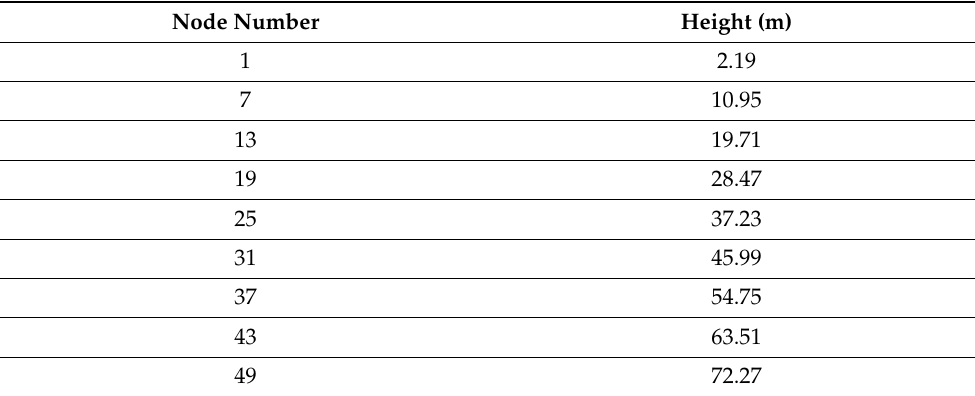
Table 14. Tower section